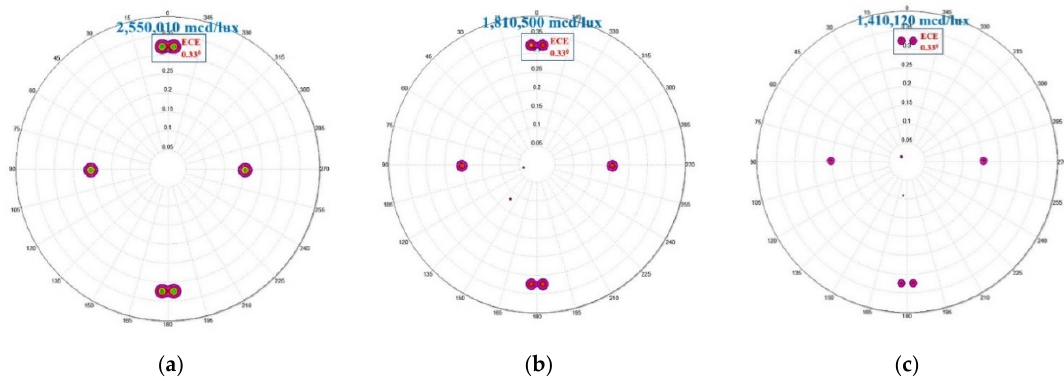
Figure 15. The R I and intensity distributions on anterior, central, and posterior regions, which are shown in: ( a – c ) Optimized ECE SuperPin Plus curved CCR. Appl. Sci. 2020 , 10 , x FOR PEER REVIEW